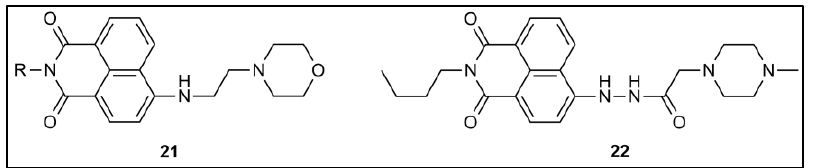
Figure 23. Naphthalimides 21 and 22 containing morpholine and N -methylpiperazine, respectively [95,96].